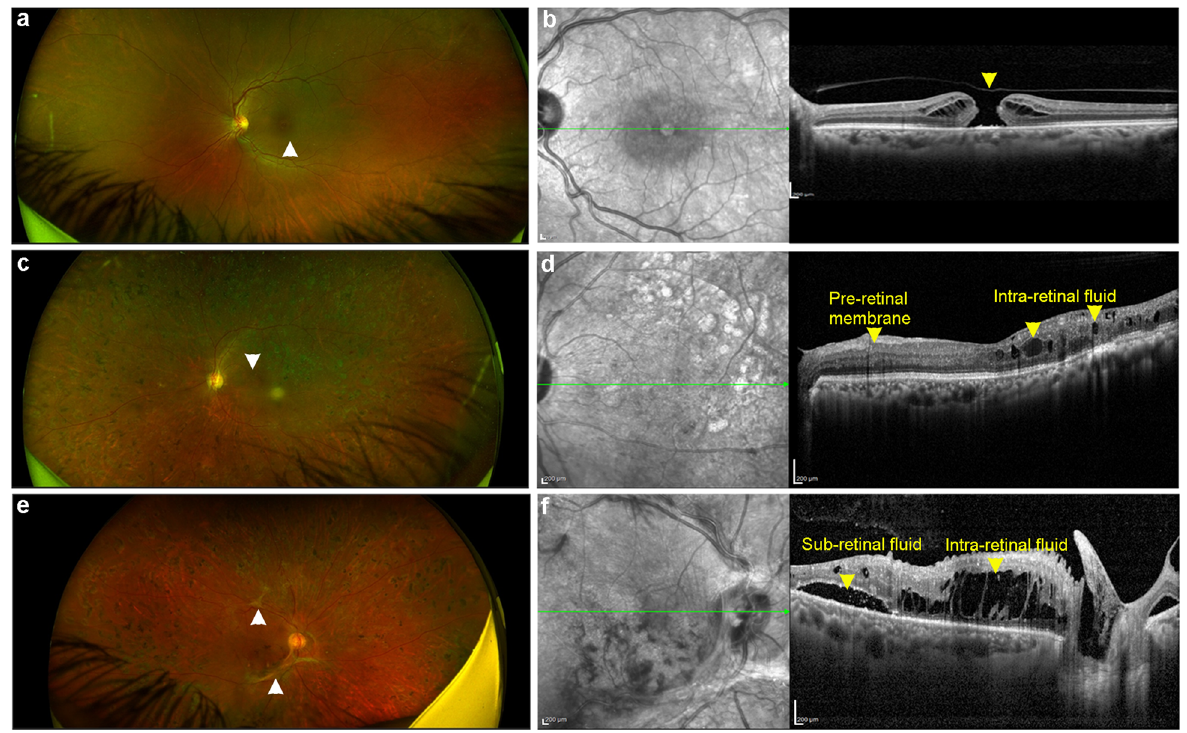
Fig. 9 Representative fundus and spectral domain-optical coherence tomography images of subjects with macular hole or proliferative diabetic retinopathy. a Fundus image of full thickness macular hole (FTMH), indicated by a white arrow head. b Spectral domain-optical coherence tomography (SD-OCT) image of FTMH, indicated by a yellow arrow head. c Fundus image of a subject with post-lasered proliferative diabetic retinopathy (PDR) with macular edema, indicated by a white arrow head. d SD-OCT image of the eye indicated in panel c shows lasered PDR with intra-retinal fl uid accumulation and pre-retinal membrane formation indicated by yellow arrow heads. e Fundus image of another subject with PDR with zones of fi brovascular proliferation indicated by white arrow heads. f SD-OCT image of the eye indicate in panel e shows presence of sub-retinal and intra-retinal fl uid accumulation indicated by arrow heads. Scale bar, 200 μ m ( b , d , f